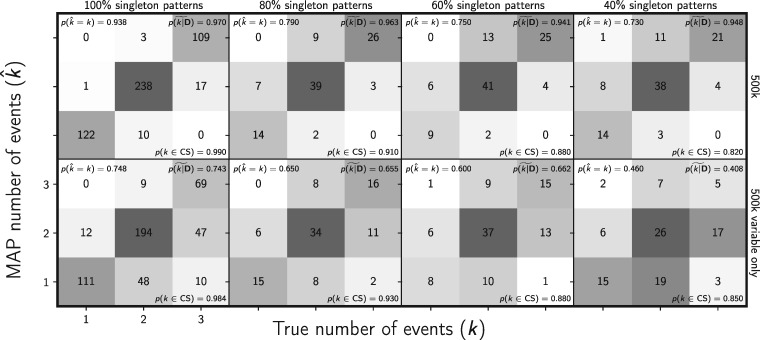
Assessing the effect of an acquisition bias against rare allele patterns on the ability of the new method to estimate the number of divergence events. The columns, from left to right, show the results when each simulated 500,000-character data set has a probability of 100%, 80%, 60%, and 40% of sampling each simulated singleton pattern. For example, each character matrix analyzed in the far right column is missing approximately 60% of characters where all but one gene copy has the same allele. For comparison, the first column shows the results of the 500 data sets from Figure 4; the remaining columns show the results of 100 data sets. The rows show the results when (top) all sites and (bottom) only variable sites are analyzed. The number of data sets that fall within each possible cell of true versus estimated numbers of events is shown, and cells with more data sets are shaded darker. The estimates are based on the number of events with the maximum a posteriori (MAP) probability. For each plot, the proportion of data sets for which the number of events with the largest posterior probability matched the true number of events—\documentclass[12pt]{minimal}
\usepackage{amsmath}
\usepackage{wasysym}
\usepackage{amsfonts}
\usepackage{amssymb}
\usepackage{amsbsy}
\usepackage{upgreek}
\usepackage{mathrsfs}
\setlength{\oddsidemargin}{-69pt}
\begin{document}
}{}$p(\hat{{k}} = {k})$\end{document}—is shown in the upper left corner, the median posterior probability of the correct number of events across all data sets—\documentclass[12pt]{minimal}
\usepackage{amsmath}
\usepackage{wasysym}
\usepackage{amsfonts}
\usepackage{amssymb}
\usepackage{amsbsy}
\usepackage{upgreek}
\usepackage{mathrsfs}
\setlength{\oddsidemargin}{-69pt}
\begin{document}
}{}$\widetilde{p({k}|{\mathbf{D}})}$\end{document}—is shown in the upper right corner, and the proportion of data sets for which the true number of events was included in the 95% credible set—\documentclass[12pt]{minimal}
\usepackage{amsmath}
\usepackage{wasysym}
\usepackage{amsfonts}
\usepackage{amssymb}
\usepackage{amsbsy}
\usepackage{upgreek}
\usepackage{mathrsfs}
\setlength{\oddsidemargin}{-69pt}
\begin{document}
}{}$p({k} \in \textrm{CS})$\end{document}—is shown in the lower right. All simulated data sets had three pairs of populations. We generated the plot using matplotlib Version 2.0.0 (Hunter 2007)